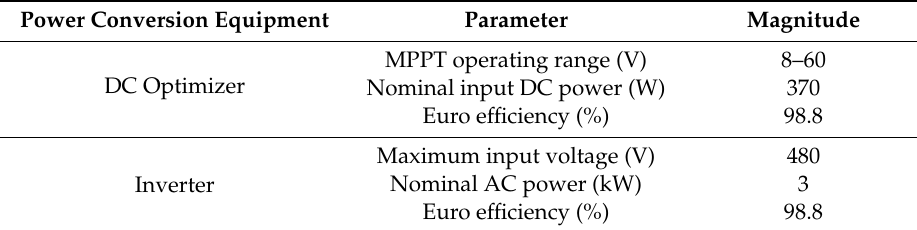
Table 3. Specification of the power conversion equipment at Testbed 3.